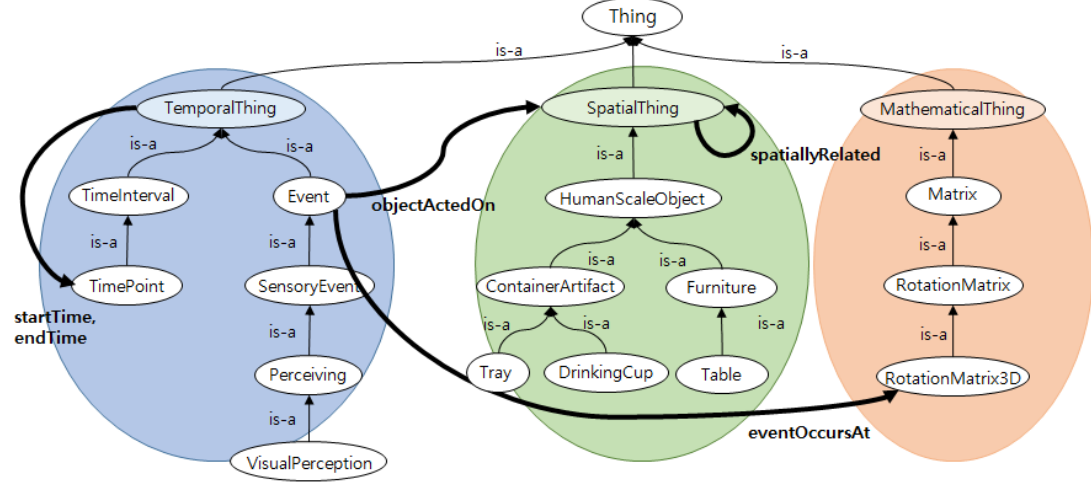
Figure 1. A part of ontology for context knowledge.